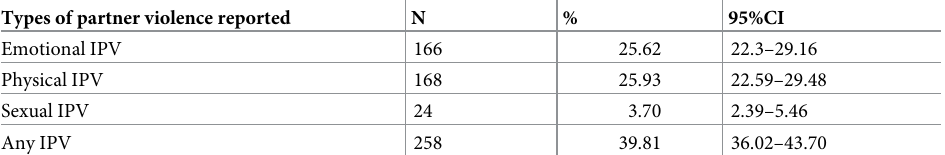
Table 5. Proportion of women who reported different aspects of IPV during pregnancy among women who had given birth in public hospitals in Harari regional state, East Ethiopia, 2018–2019.